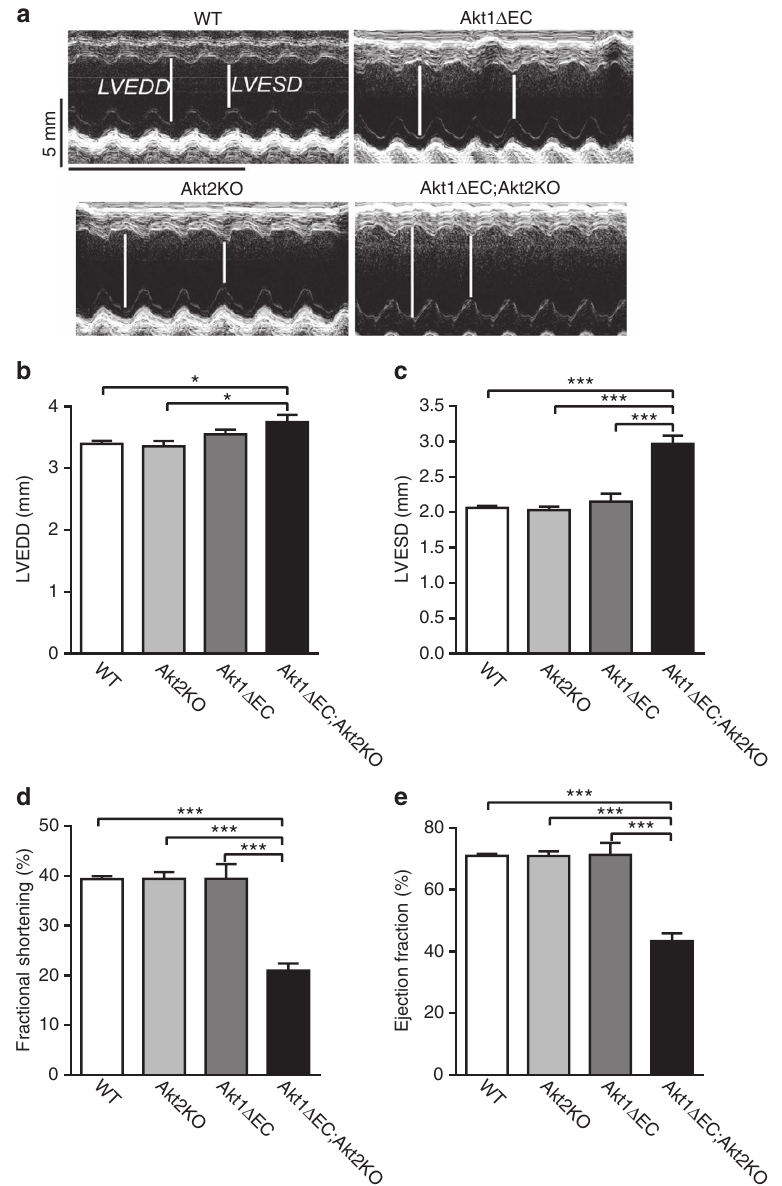
Figure 7 | Functional tissue consequences from Akt ablation. ( a ) Representative echocardiography for WT, Akt2KO, Akt1 D EC and Akt1 D EC;Akt2KO mice after 4 weeks of tamoxifen treatment. Scale bar, 100 m m. ( b – e ) LVEDD, LVESD, percentage of fractional shortening and percentage of ejection fraction calculated from echocardiography representing mean ± s.e.m. ( n ¼ 4–6). ( f ) Representative images of WT, Akt2KO, Akt1 D EC and Akt1 D EC;Akt2KO retinas after tamoxifen treatment for 4 weeks stained with haematoxylin and eosin. INL, inner nuclear layer; ONL, outer nuclear area; OPL, outer plexiform layer; OS, inner and outer photoreceptor segment; RPE, retinal pigment epithelium layer and choroid. ( g , h ) Quantification of the thickness of the outer and inner nuclear layers represented as mean percentage decrease from control ± s.e.m. ( n ¼ 3–4). ( i ) Representative images of WT, Akt2KO, Akt1 D EC and Akt1 D EC;Akt2KO retinas after tamoxifen treatment for 4 weeks stained for CD31 (red), the proliferation marker Ki-67 (green) and DAPI (blue). Scale bar, 100 m m. ( j ) Quantification of the intensity of Ki-67 staining as mean percentage of control ± s.e.m. ( n ¼ 2). * P o 0.05, ** P o 0.01 and *** P o 0.005 by one-way analysis of